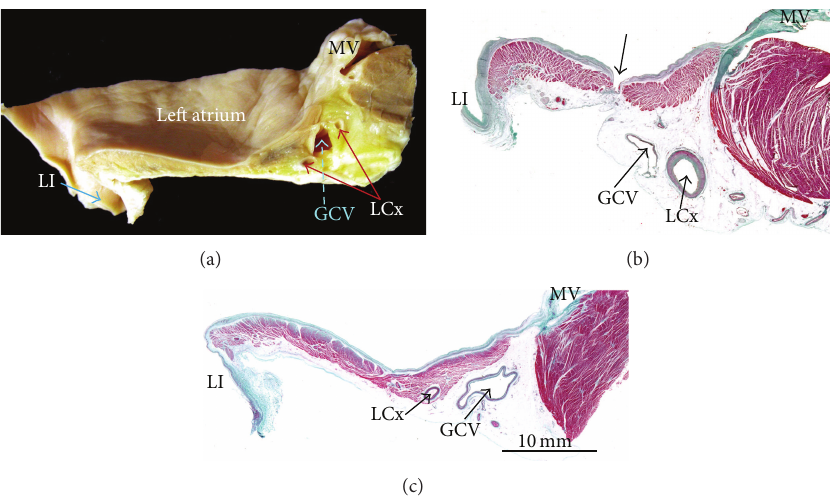
Figure 9: Longitudinal sections at the mitral isthmus to illustrate its anatomic relations with the great cardiac vein/coronary sinus and left circumflex artery. (a) This cut shows in profile the mitral isthmus between the mitral annulus and the orifice of the left inferior pulmonary vein. (b) and (c) These corresponding histological sections stained with Masson’s trichrome show the irregular length and thickness of the atrial wall and the relationship to the great cardiac vein/coronary sinus. Note in (b) the space between the pectinate muscles where the left posterior atrial wall becomes thinner (arrow). LI = left inferior pulmonary vein, MV = mitral valve, LCx = left circumflex artery, and GCV = great cardiac